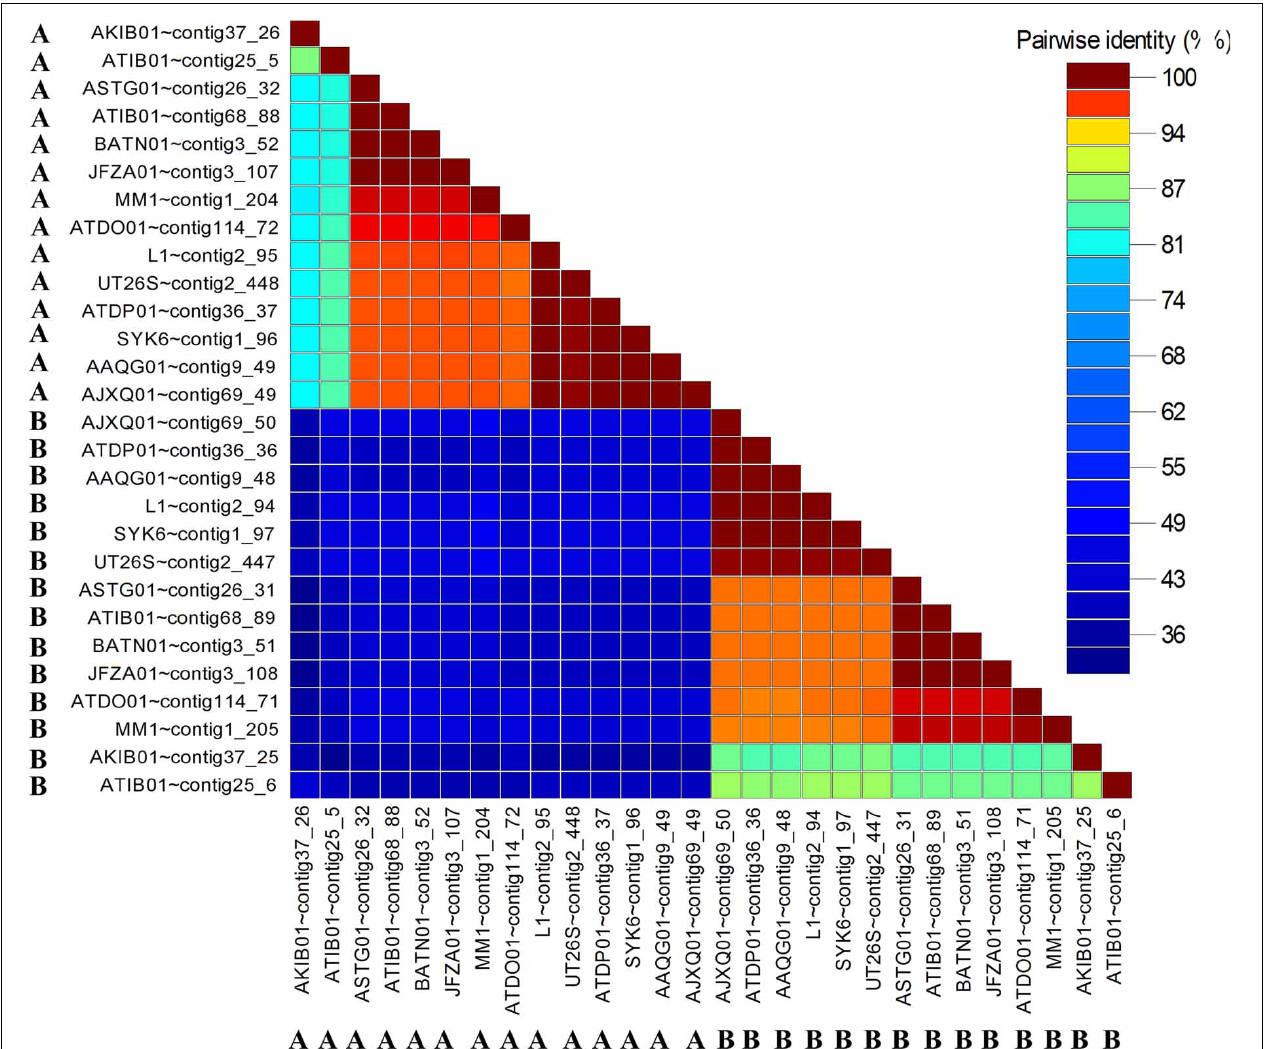
FIGURE 6 | Pairwise identity matrix of identified convergent luxR-luxR-luxI (LuxR-A and LuxR-B) in sphingomonads. The letters A and B correspond to different partner luxRs in the